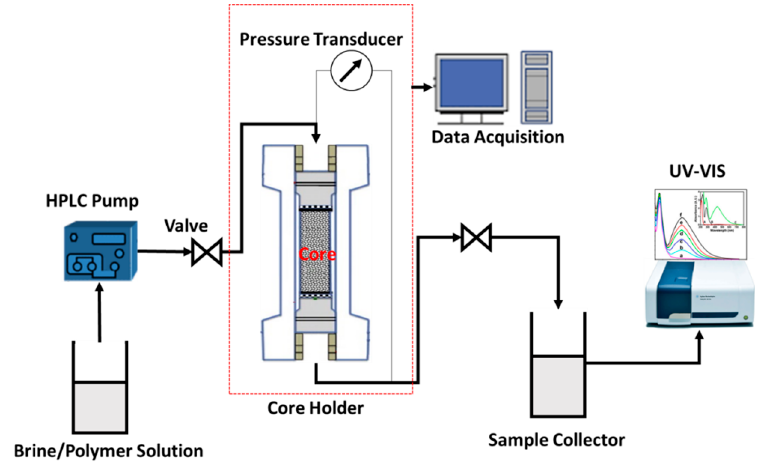
Figure 1. Schematic of the unit used for polymer retention determination.